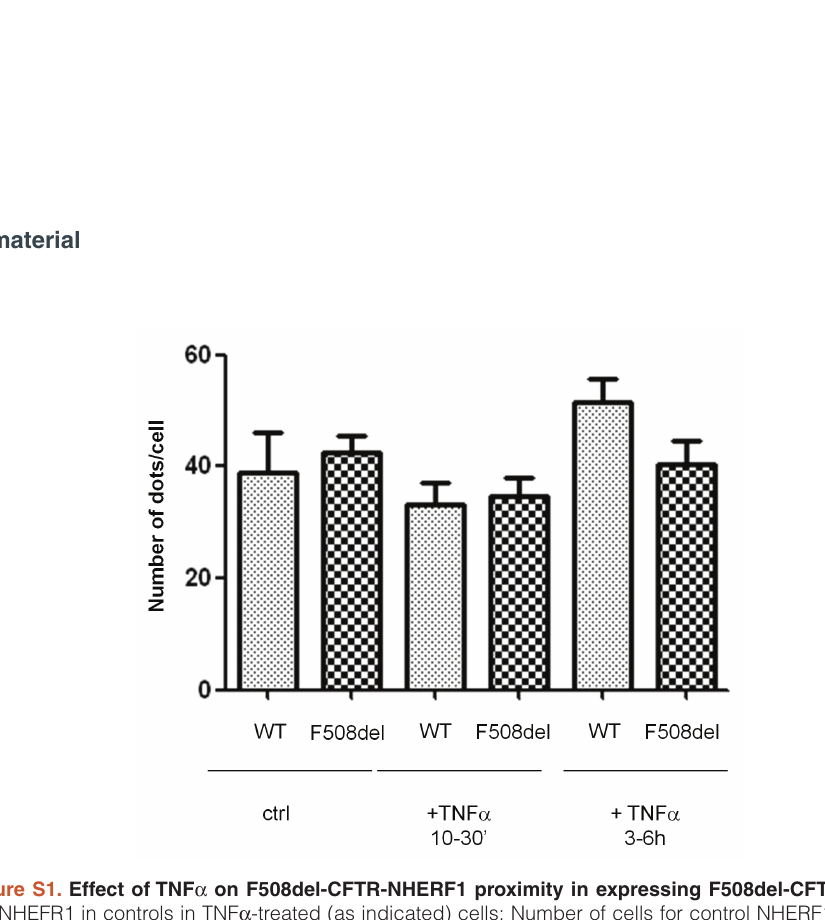
Figshare: Raw data for Bitam et al. , 2015 ‘An unexpected effect of TNF α on F508del-CFTR maturation and function.’ doi: 10.6084/ m9.figshare.1476156 36